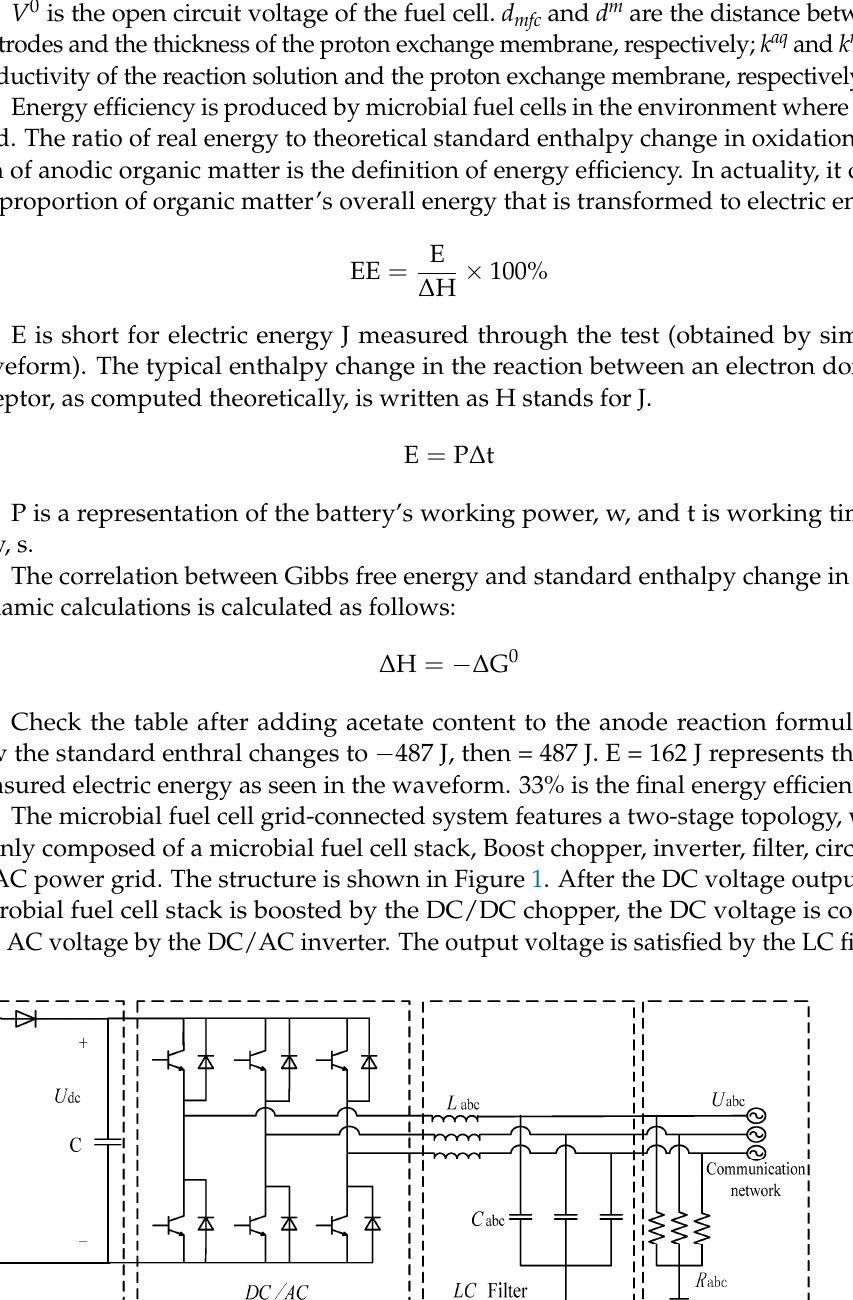
R Figure 2. DC converter circuit. Figure 3. Waveform of voltage and current on load. The duty cycle of the switches in the above circuit can be defined as follows: on S t D T  (21) where T s is the working period of switch T, and t on is the on-off time of switch T. The average output voltage can be obtained from the waveform diagram.